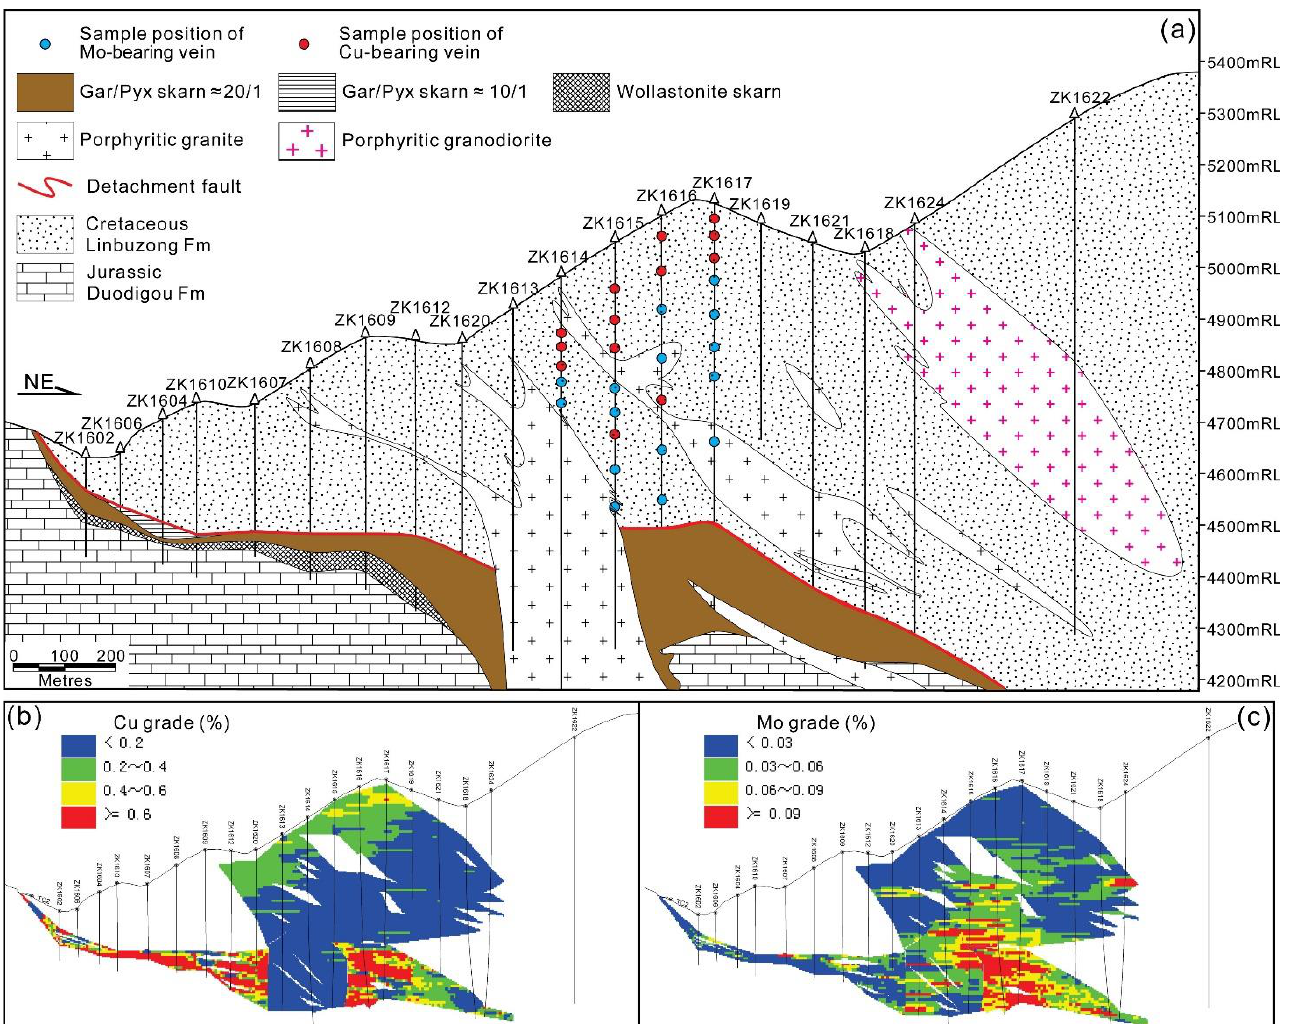
Figure 2. Cross-section No. 16 through the center of the porphyry–hornfels orebody. ( a ) Geological cross-section; ( b , c ) grade block models, showing the metal zonation characterizing the upper Cu and lower Mo zones in the porphyry–hornfels. The location of the section is shown in Figure